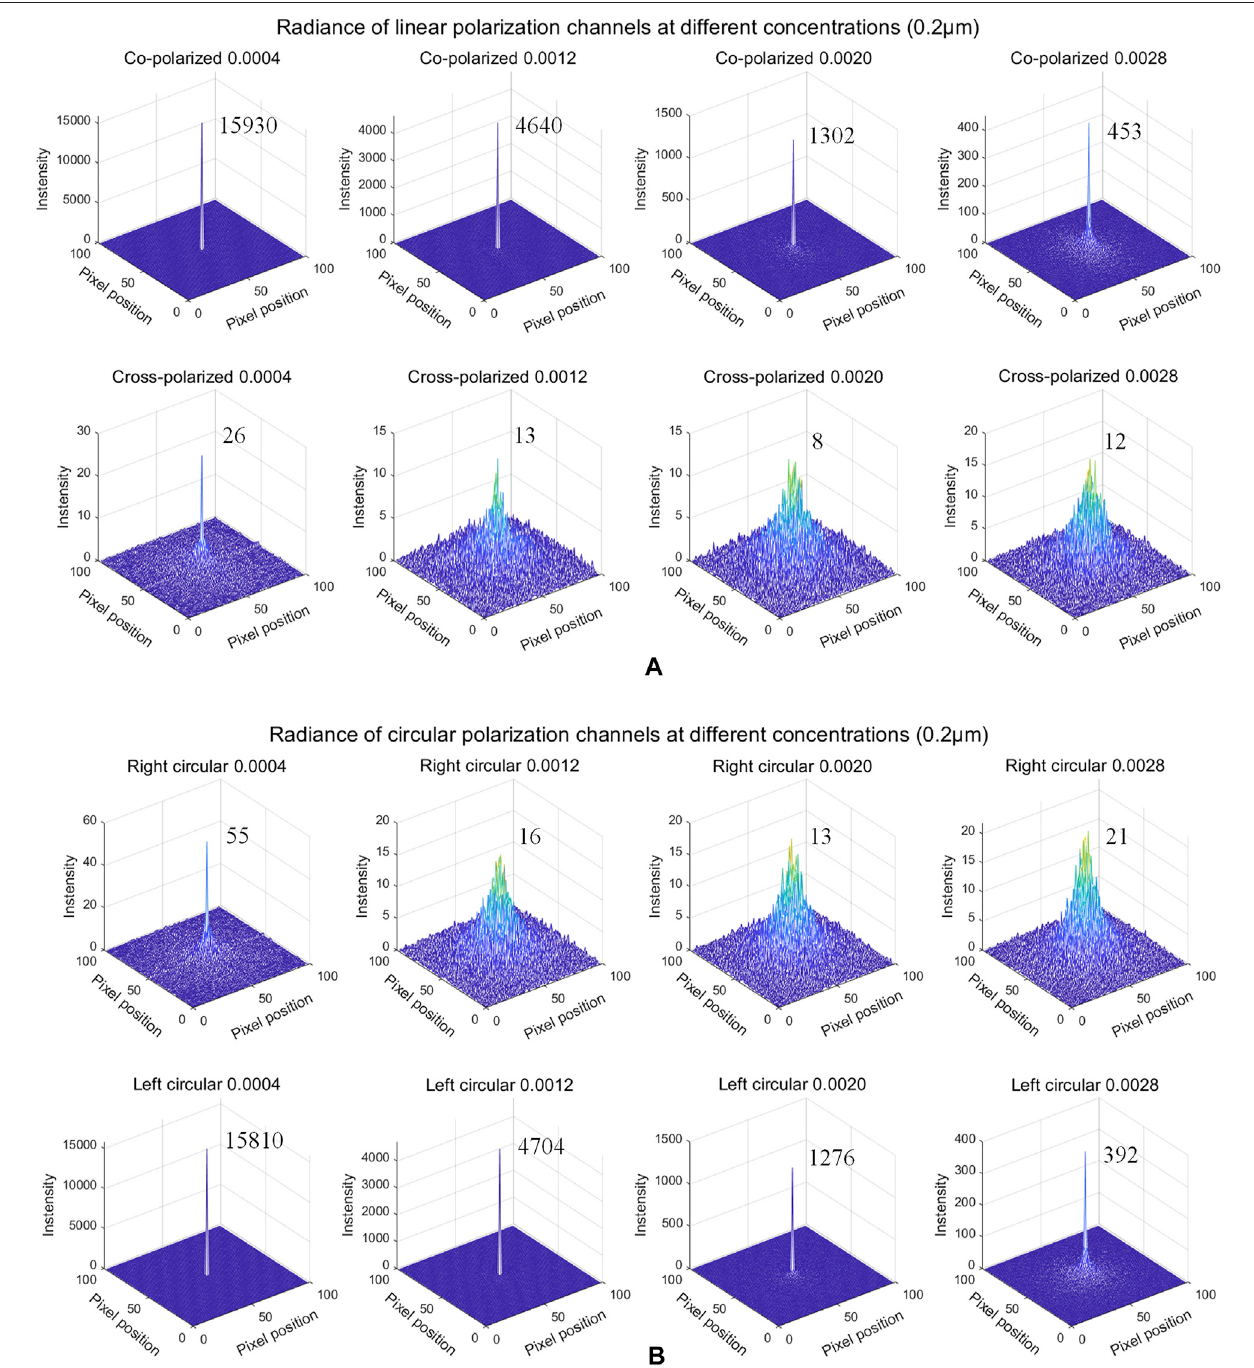
FIGURE 2 | Radiance of polarization channels at different concentrations in the medium with small-sized particles (0.2 μ m). (A) co-polarized and cross-polarized radiance, (B) right circular and left circular polarized radiance.